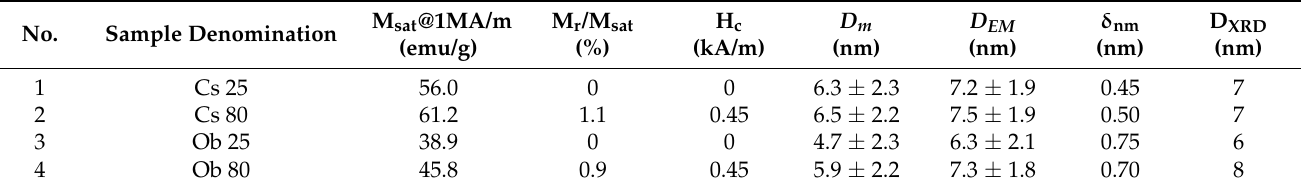
Table 3. Magnetic characteristics of the